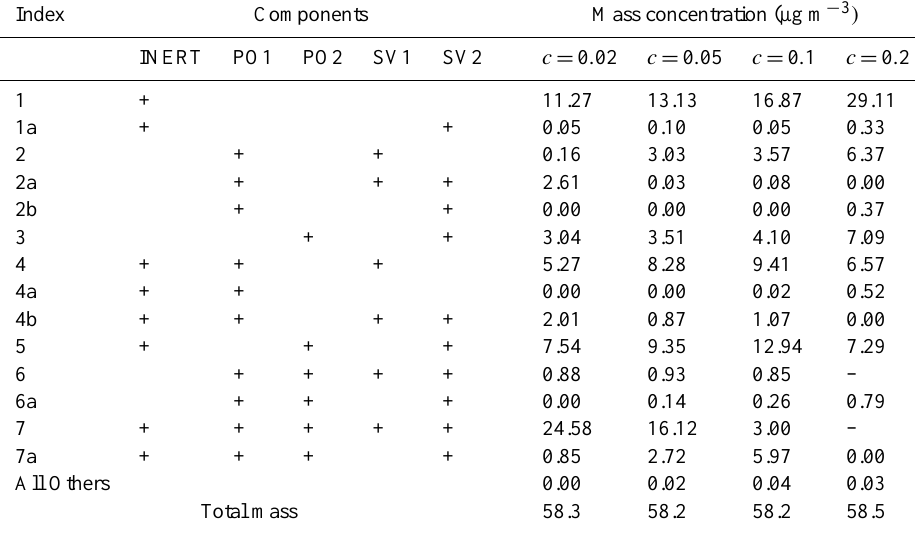
Table 6. Major populations ∗ formed at t =188 h in base case external mixture simulations with different mixing